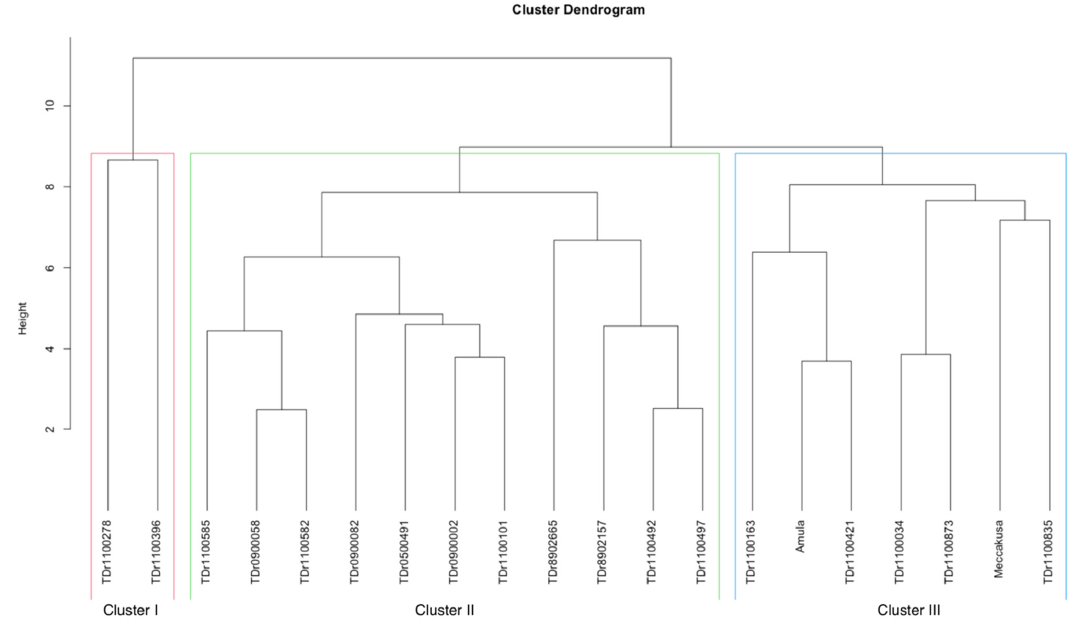
Figure 3. Cluster analysis of predicted best linear unbiased prediction (BLUP) values of starch pasting properties between genotypes.